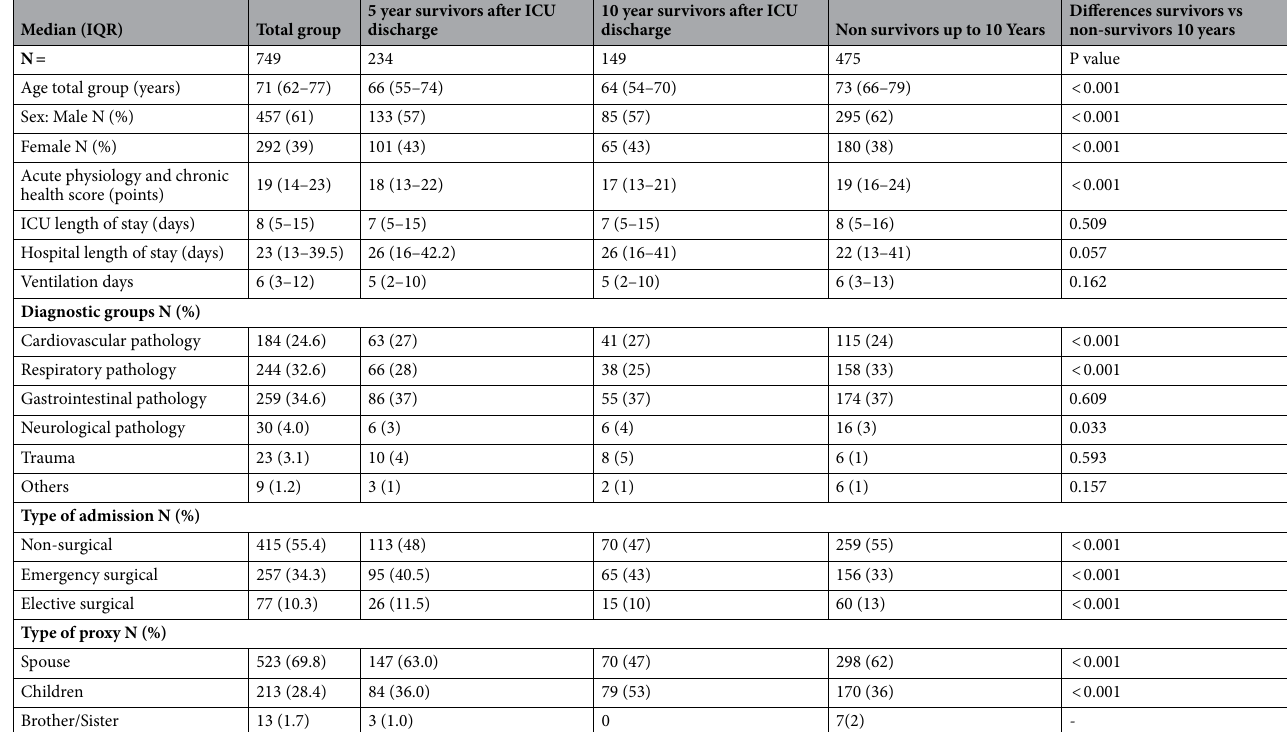
Table 2. Demographic and clinical characteristics of patients included in the study. Elective surgical: ICU admission was planned within a 24 h period before surgery, Emergency surgical: unplanned surgery, Non- surgical: all other admissions. Values indicate medians and interquartile range (P 25 -P 75 ) unless stated otherwise Only important diagnostic groups were added.